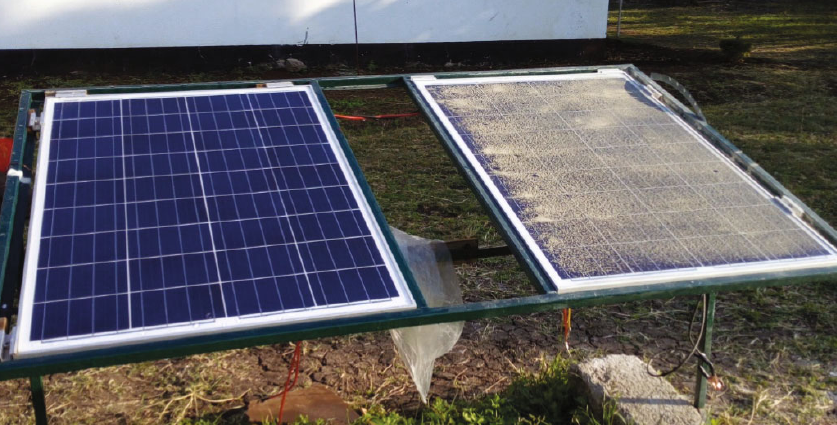
Figure 3: PV module experimental setup.